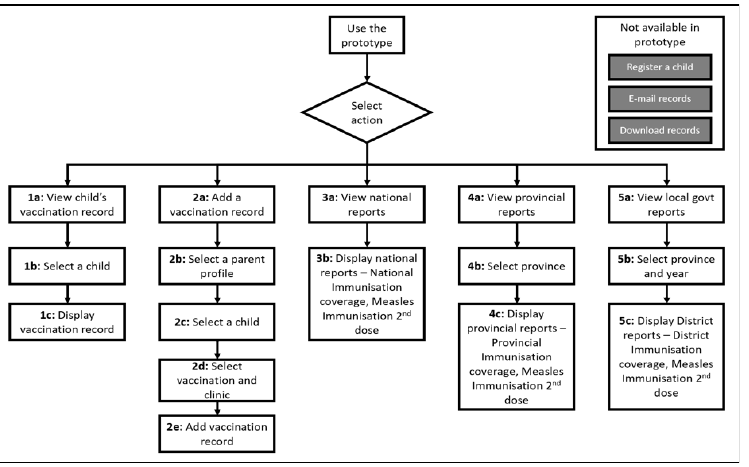
Figure 3: Process flows for parents